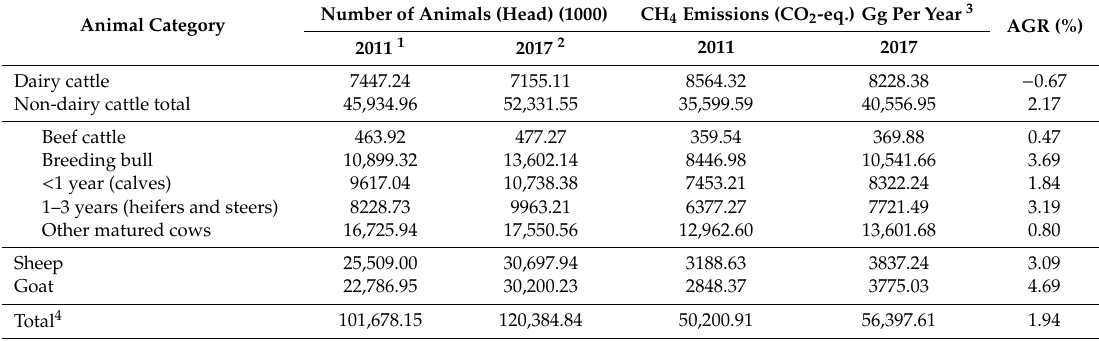
Table 1. Estimated enteric CH 4 emissions from ruminant livestock in Ethiopia, annual growth rate, and temporal variations over the period